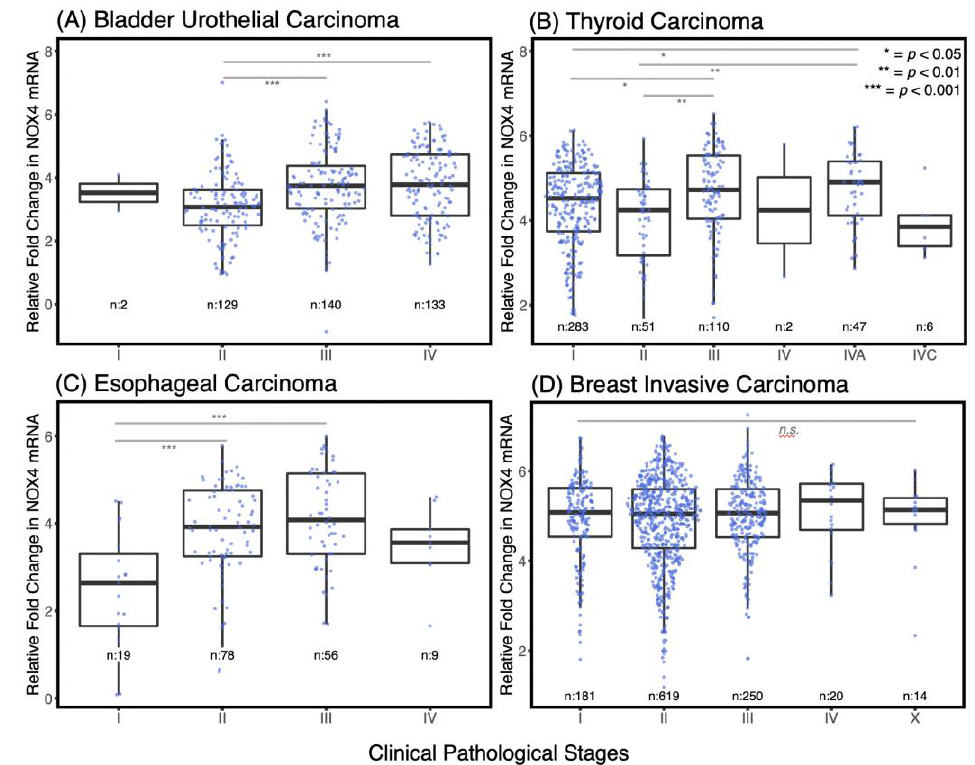
Figure 2. NOX4 mRNA levels are increased in the advanced stages of several cancer types. Samples were grouped by studies and subdivided into clinical stages. Boxplots representing the relative fold change in NOX4 mRNA (natural log of NOX4 RNA-seq by expectation-maximization (RSEM) values) were generated and Kruskal–Wallis rank sum tests along with post hoc Dunn tests for multiple comparisons were used to determine the significance in variance and the adjusted p -values. In bladder, thyroid and esophageal carcinoma, NOX4 mRNA levels generally increase as the cancers progress (( A – C ), respectively), although NOX4 remained unchanged in breast carcinoma ( D ). The number of samples is indicated below each bar.